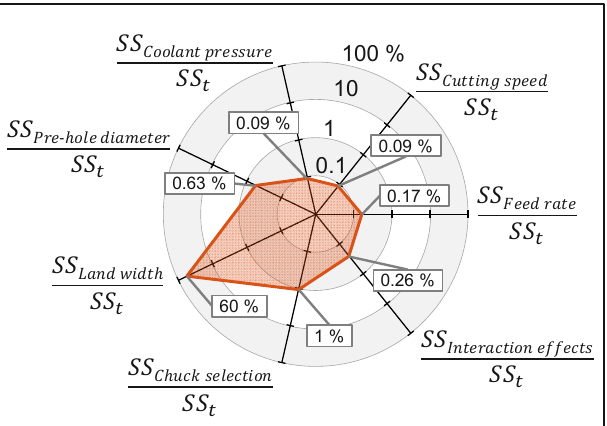
Figure 5. Influence of each varied parameter on total circularity scattering. Table 2. ANOVA ‑ Table.